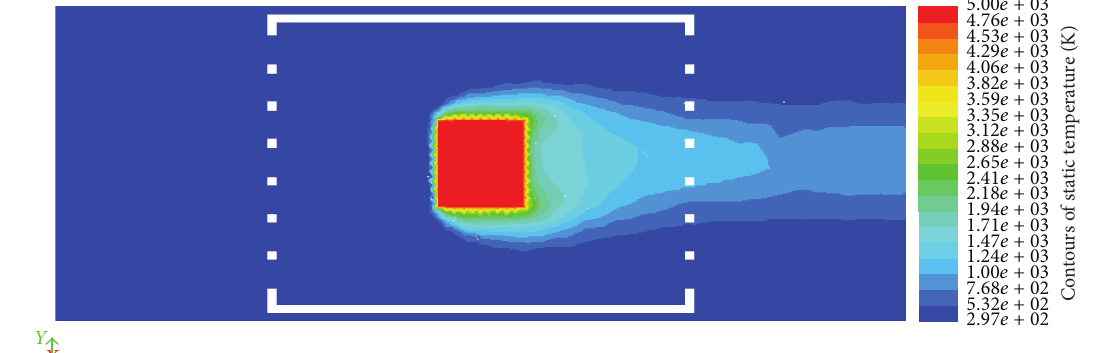
Figure 14: Temperature field distribution of the square hole in the section 𝑋 = 0